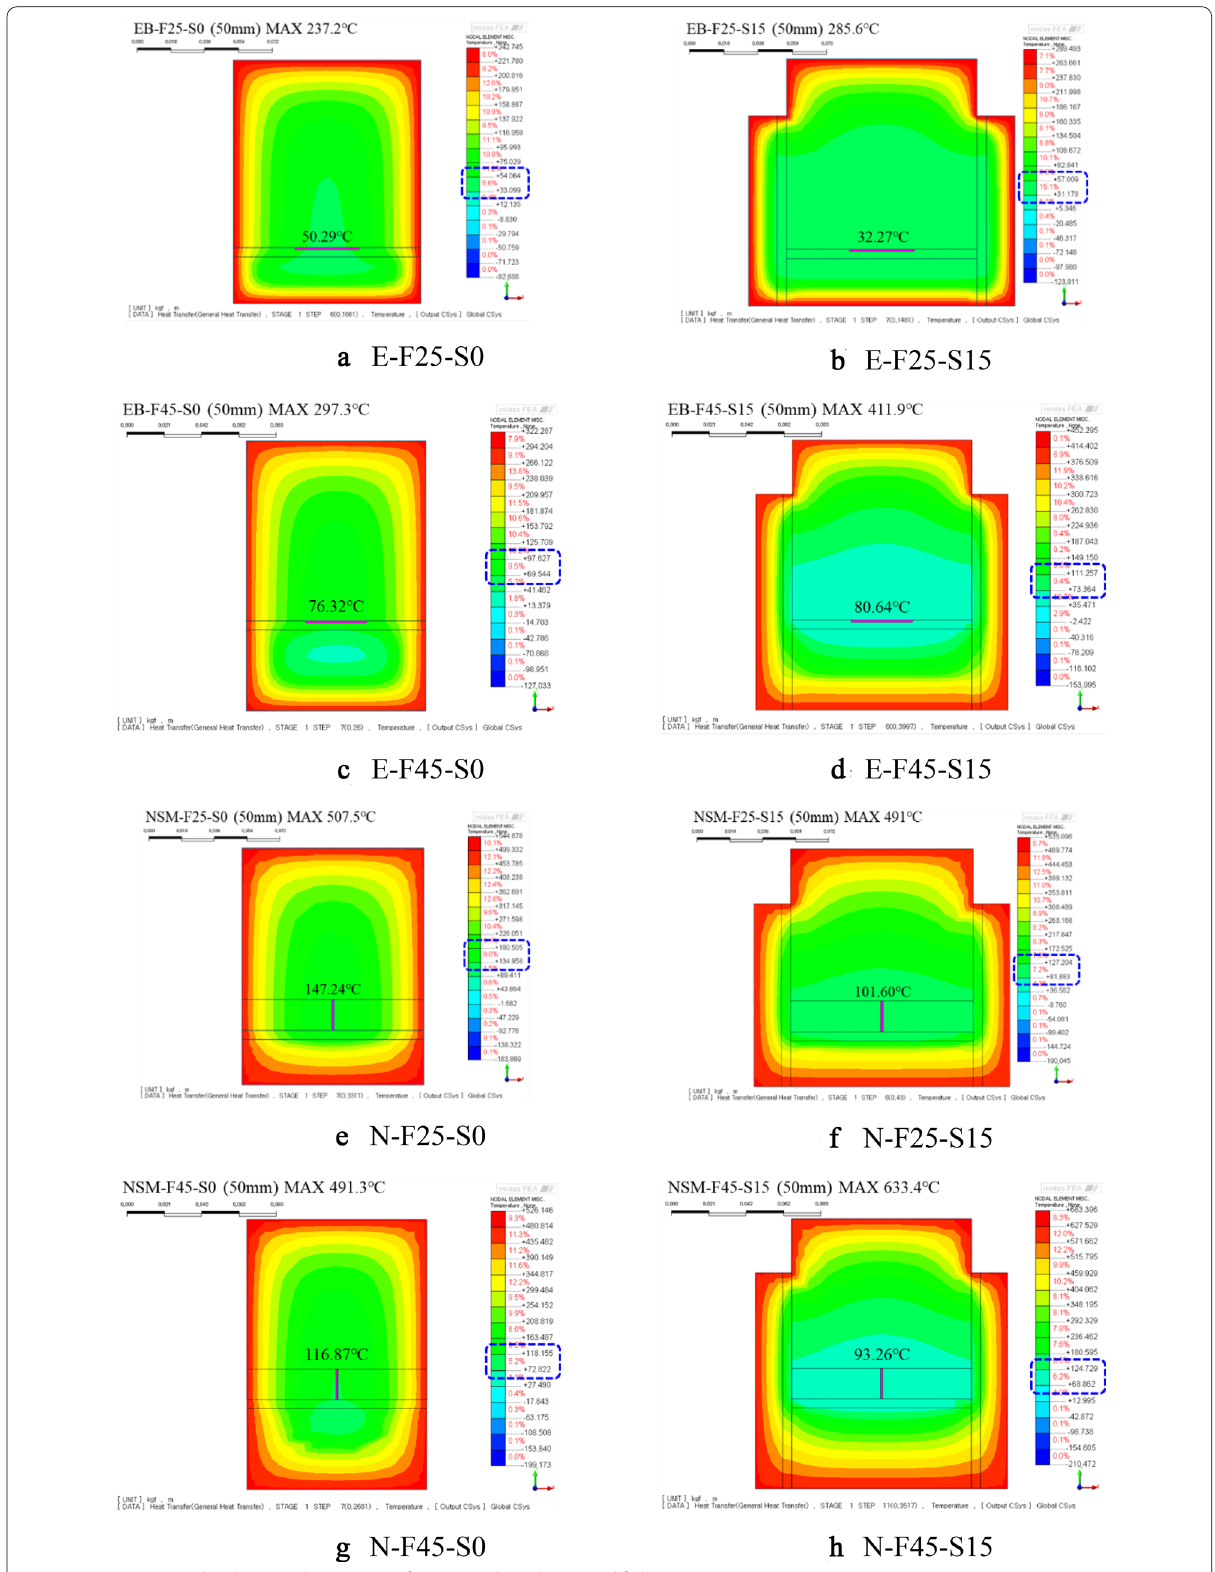
Fig. 28 Temperature distribution plot at 50mm from the edge when bond failure